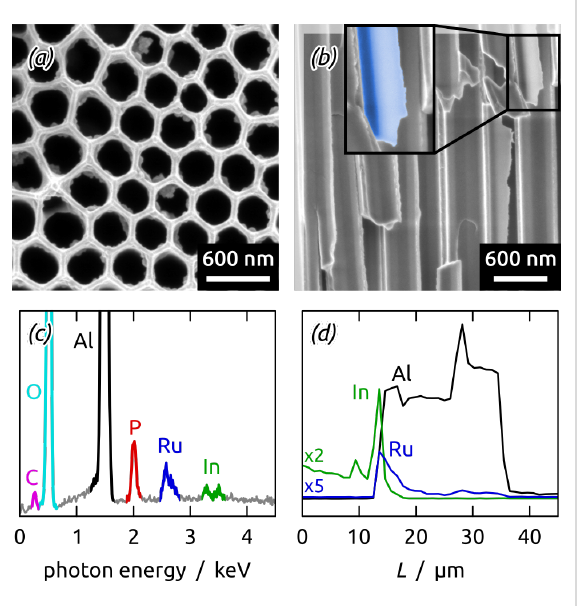
Figure 6: Scanning electron micrographs of a nanostructured Ru/C sample after all preparation steps in top view (a) and cross-section (b). EDX spectrum recorded over the whole sample length L = 24 μ m (c). EDX profile taken along the cross-section (d). Laser-irradiation of Ru 3 (CO) 12 solutions results in thin ruthenium containing coatings along the whole length of Al 2 O 3 pores.